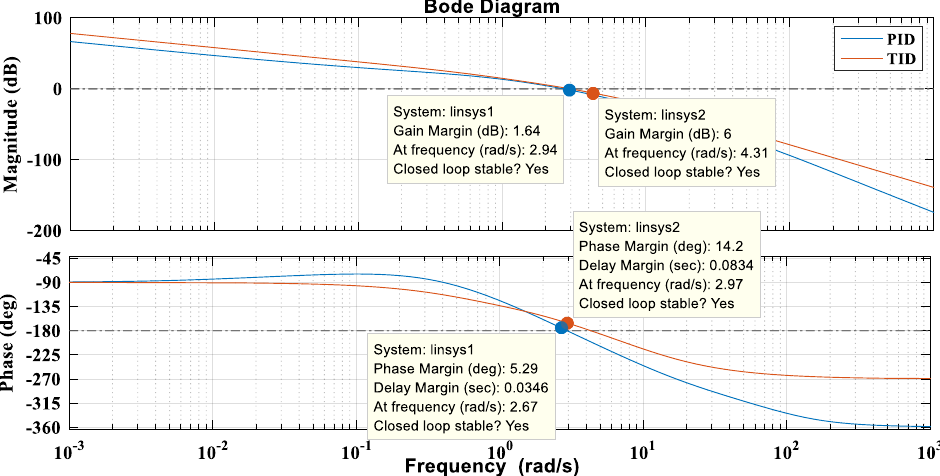
Figure 19. Bode plot analysis of PID and TID controllers.